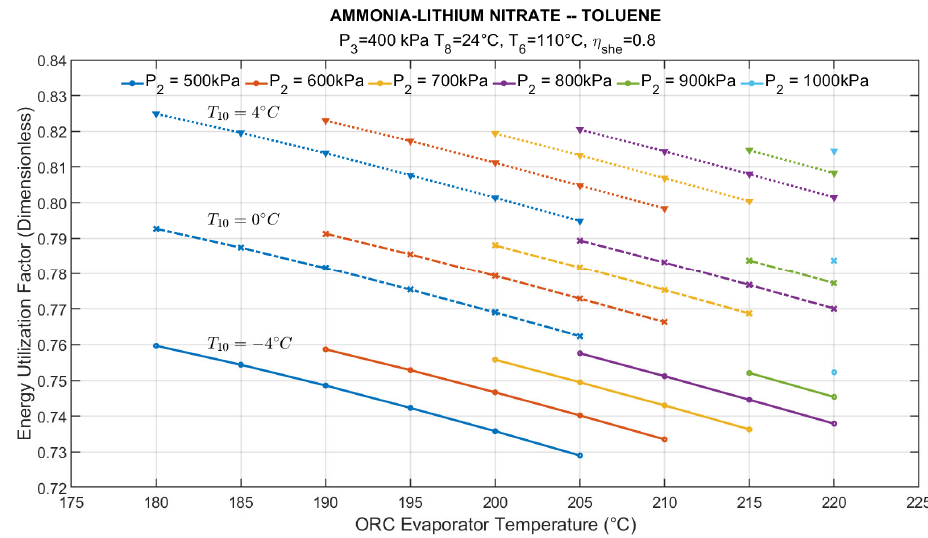
Figure 17. NH 3 -LiNO 3 –C 7 H 8 effect of heat source and cooling temperatures on the EUF.